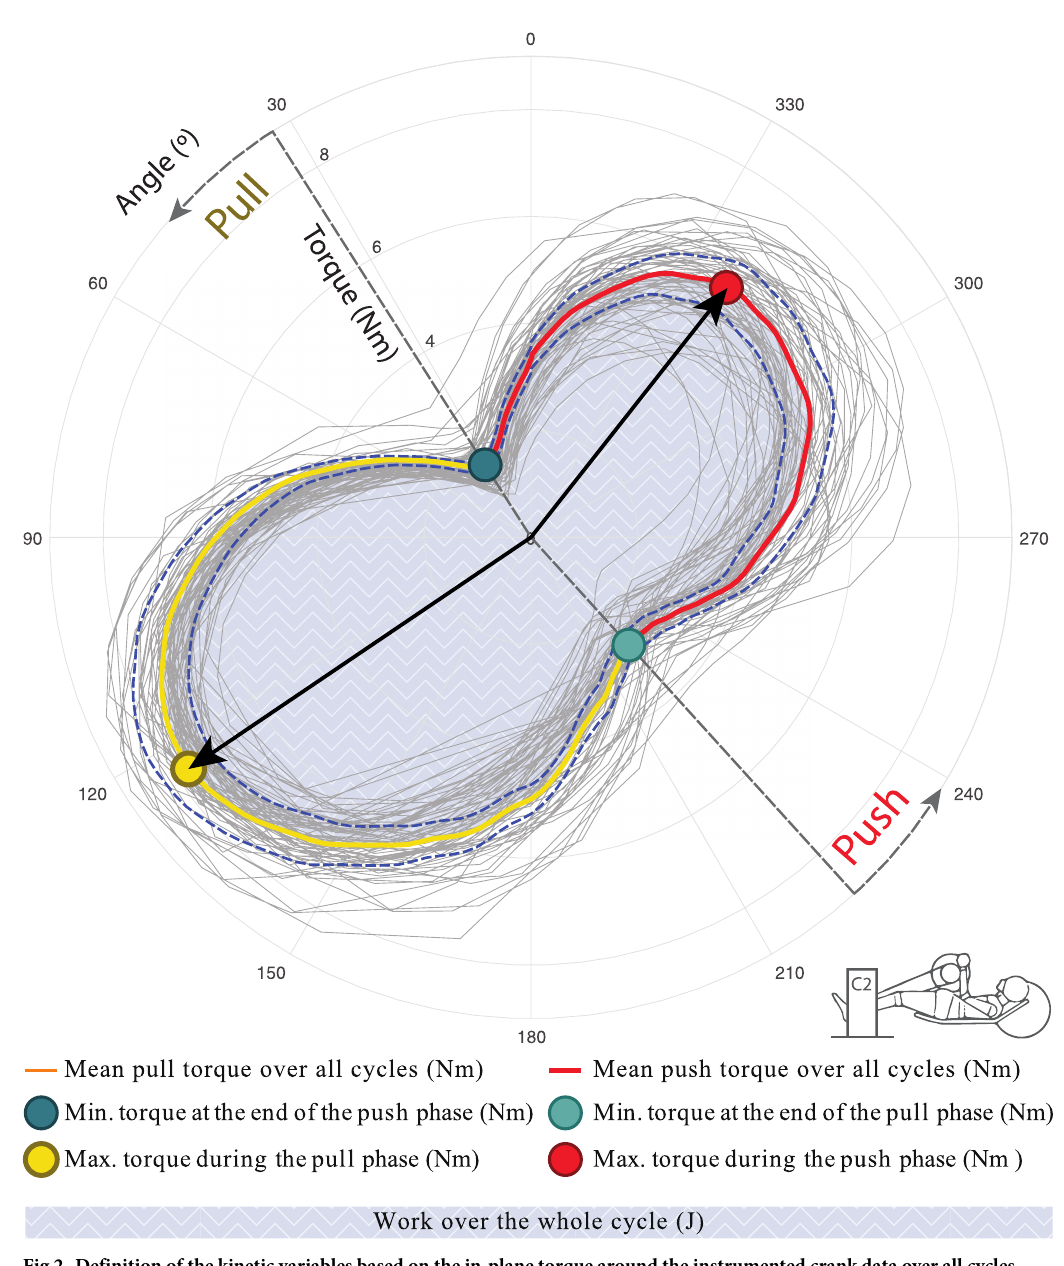
Fig 2. Definition of the kinetic variables based on the in-plane torque around the instrumented crank data over all cycles from a single trial of a single participant. C2 stands for Cyclus2 (Handcycle ergometer).